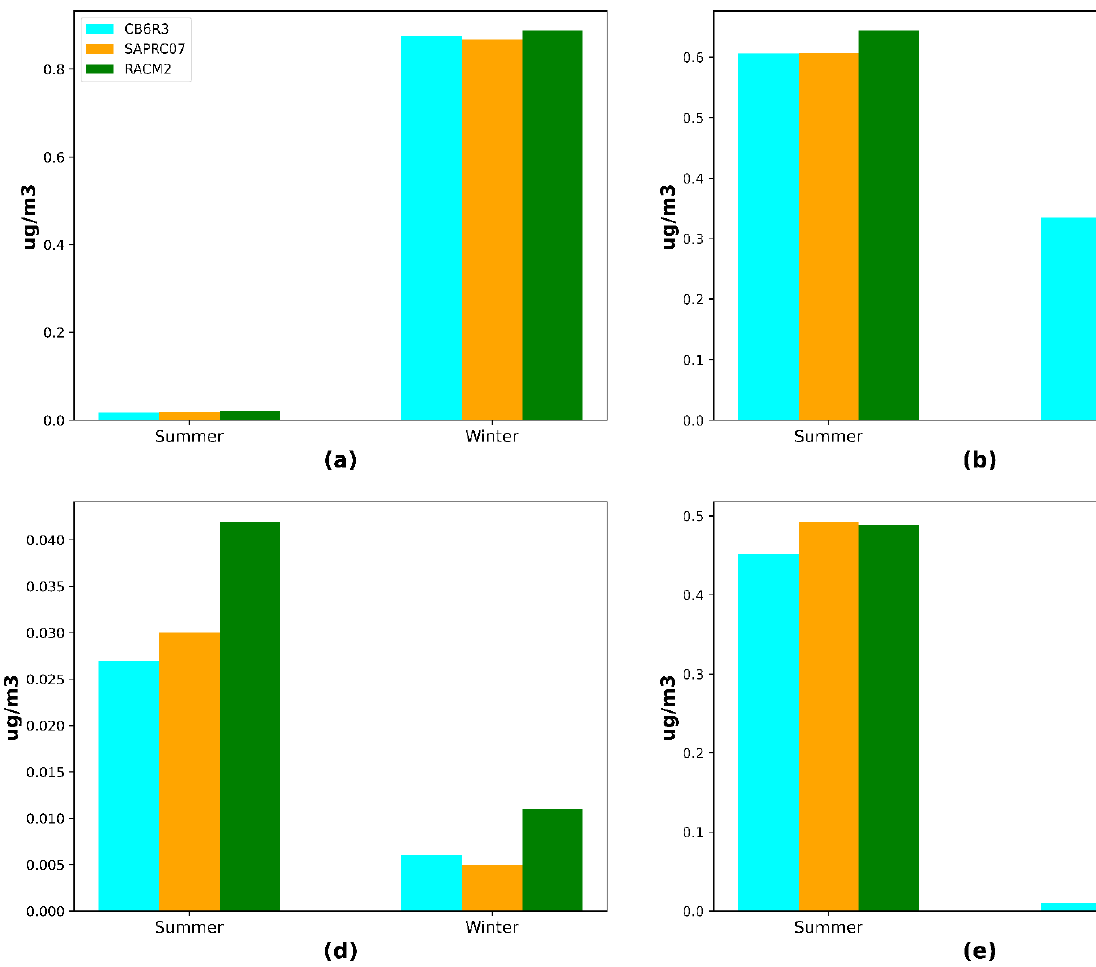
Figure 8. Comparison of CB6R3, SAPRC07, and RACM2 predicted monthly mean values for ( a ) Nitrate, ( b ) Sulphate ( c ) Ammonium, ( d ) SOA-Anthropogenic, ( e ) SOA-Biogenic, ( f ) Total fine particulate (PM 2.5 ).